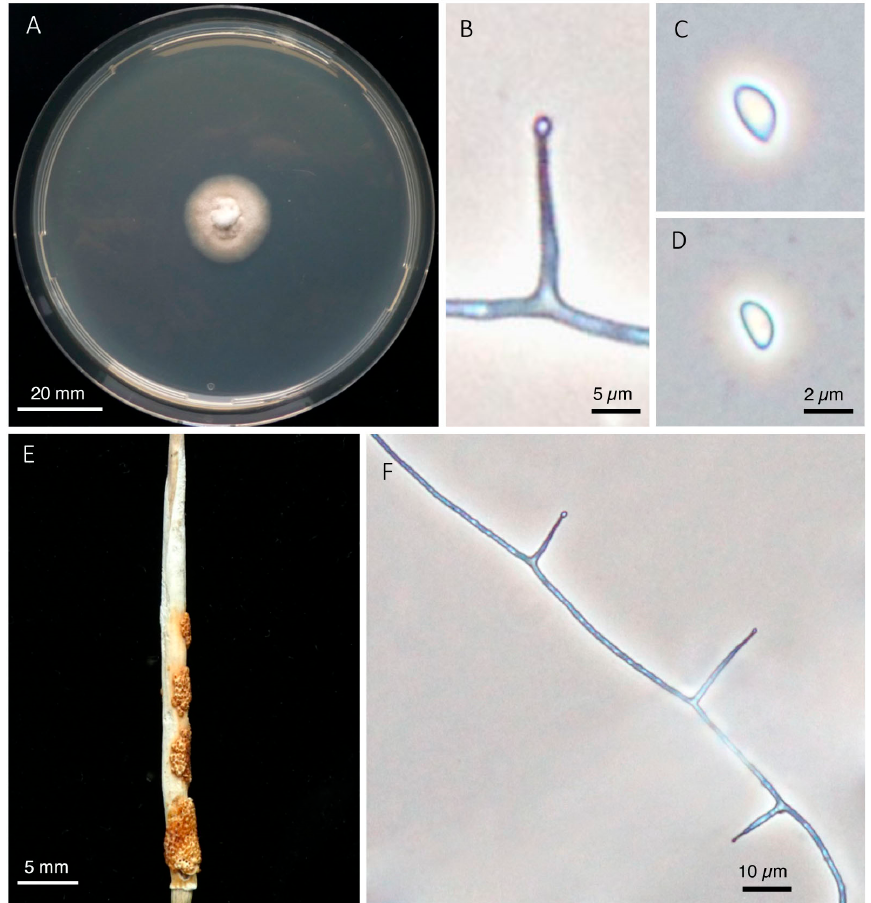
Figure 5. Epichloë calamagrostidis. ( A ). Colony grown on PDA for 21 days at 24 °C. ( B ). Conidioge- nous cell with emerging conidium. ( C , D ). Conidia. ( E ). Stroma with mature perithecia on C. varia (coll. H. Seitter). ( F ). Sporulating hypha in culture.